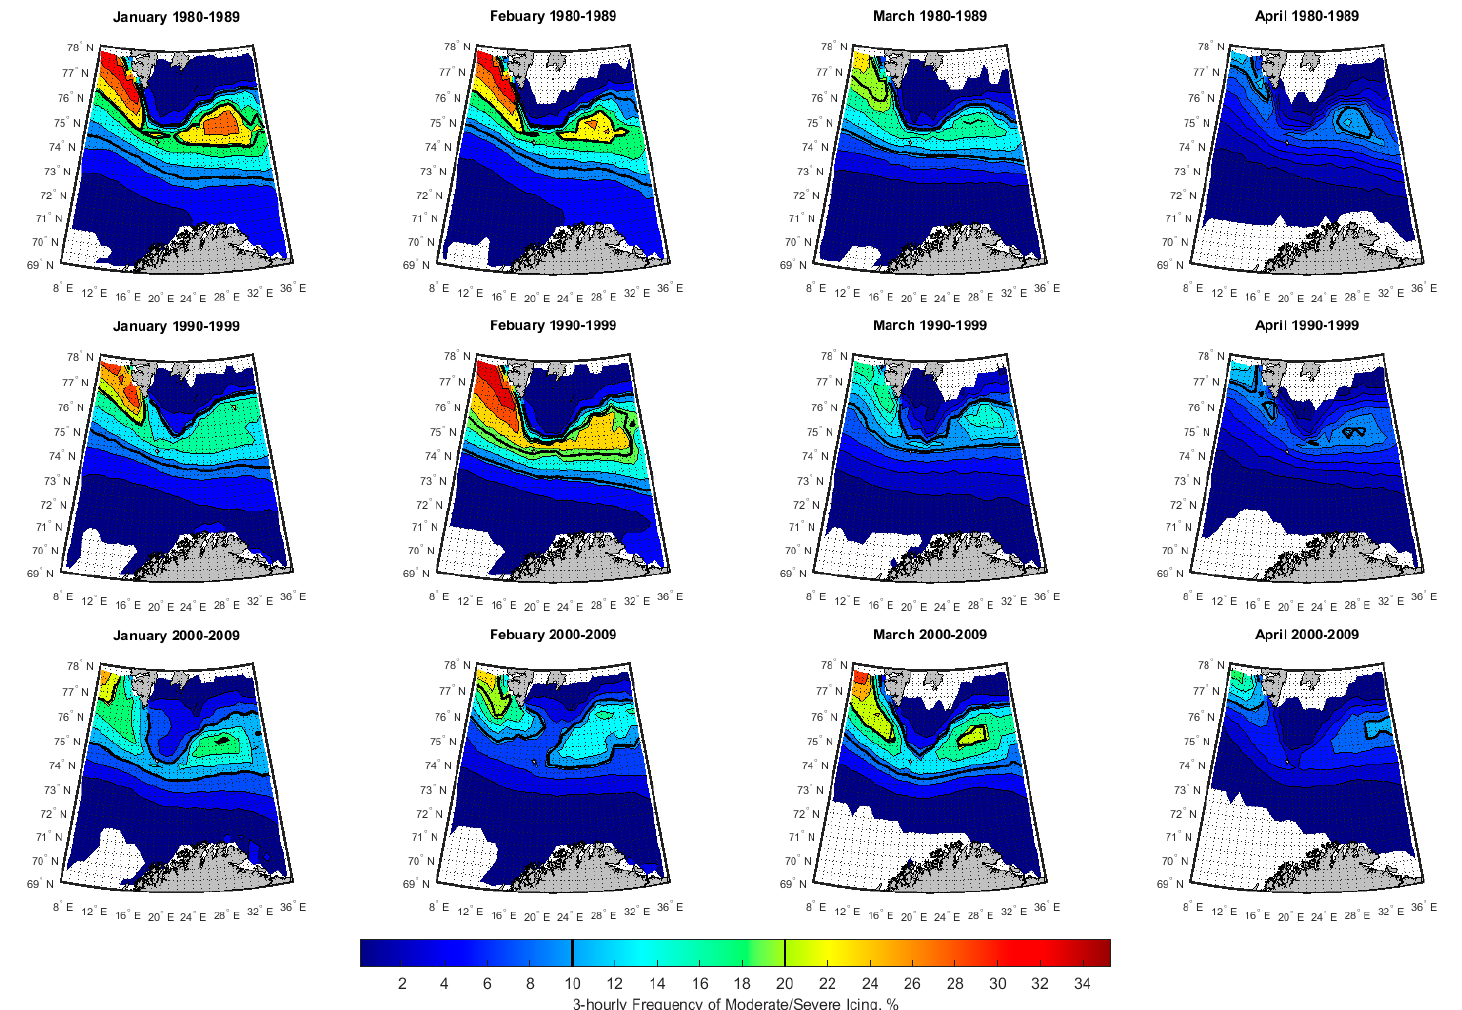
Figure 16. Three-hourly frequency of moderate and severe icing events in each region during the 1980s, 1990s, and 2000s (Jan, Feb, Mar, Apr).